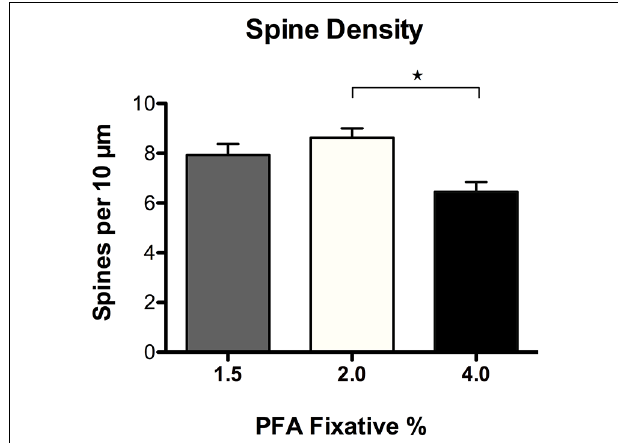
FIGURE 6 | Spine density analysis of DiI labeled neurons fixed with varying concentrations of paraformaldehyde (PFA). No significant differences in spine density were observed in neurons fixed with 1.5% or 2.0% PFA. Neurons fixed with 2.0% PFA yielded significantly higher spine densities when compared to neurons fixed with 4.0% PFA (* p <